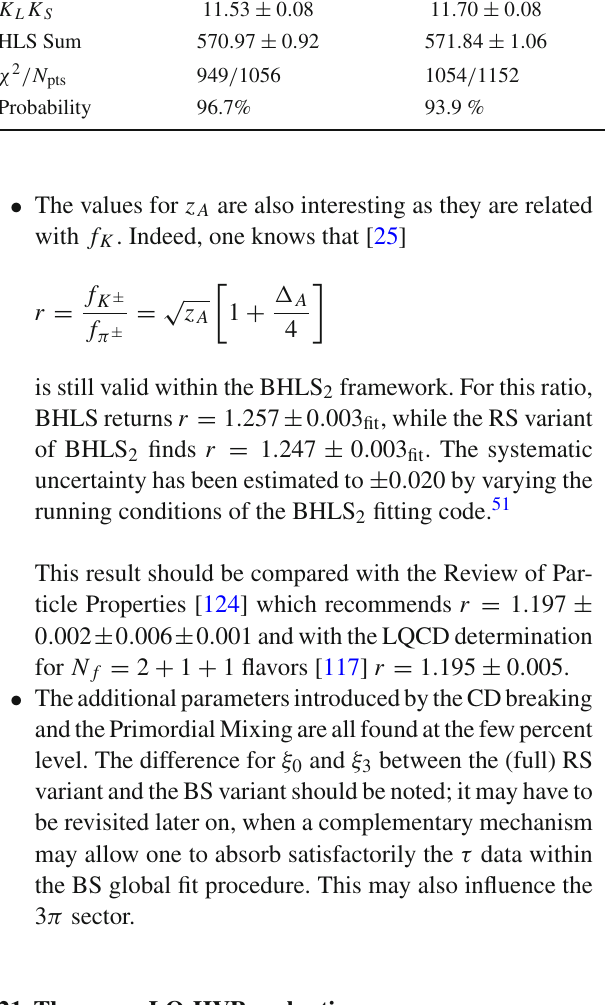
for BHLS 2 using the largest set of data samples, keeping or discarding the τ data. The last data column refers to the numerical integration for eachchannelofthesamesetofdatawhichareusedintheBHLS/BHLS 2